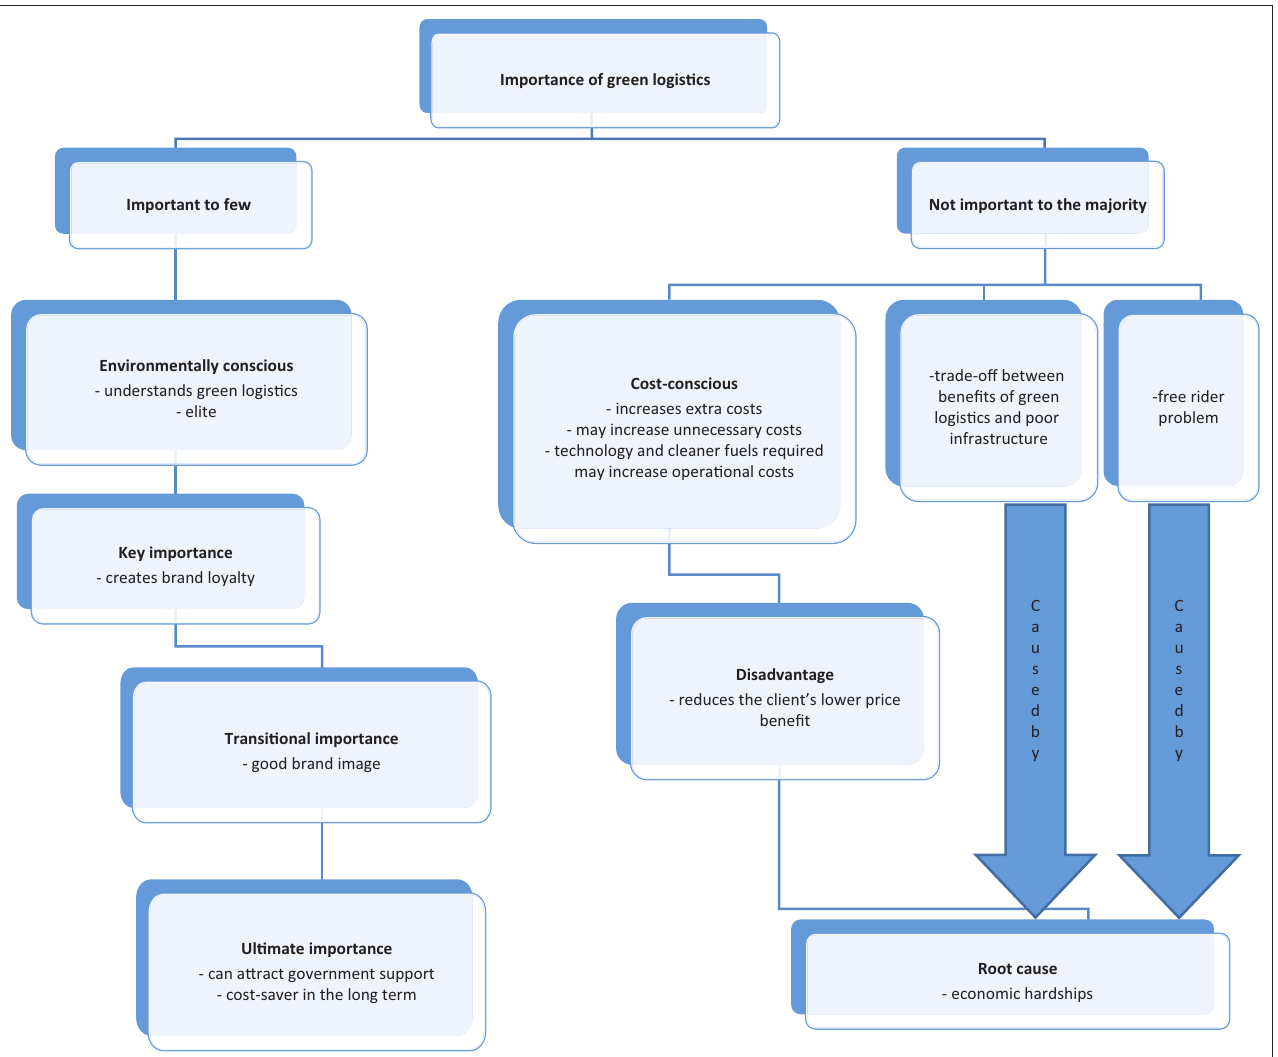
FIGURE 4: A hierarchical analysis of the importance of green logistics.